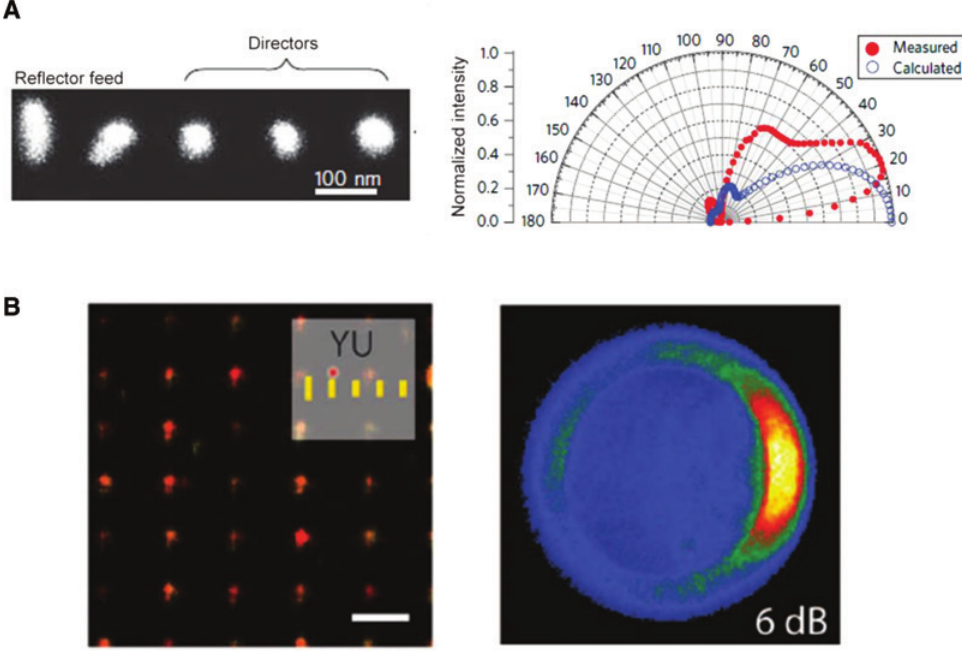
Figure 9: Optical rod Yagi-Uda antennas. (A) Schematics of optical rod Yagi-Uda antenna (left) and the directional radiation (right). (B) Optical image of the coupling between quantum dot radiation and optical Yagi-Uda antenna (left) and the measured Fourier space image of the directional radiations from this coupling (right). (A) Reprinted with permission from Ref. [8]. Copyright 2010 Springer Nature. (B) Reprinted with permission from Ref. [28]. Copyright 2010